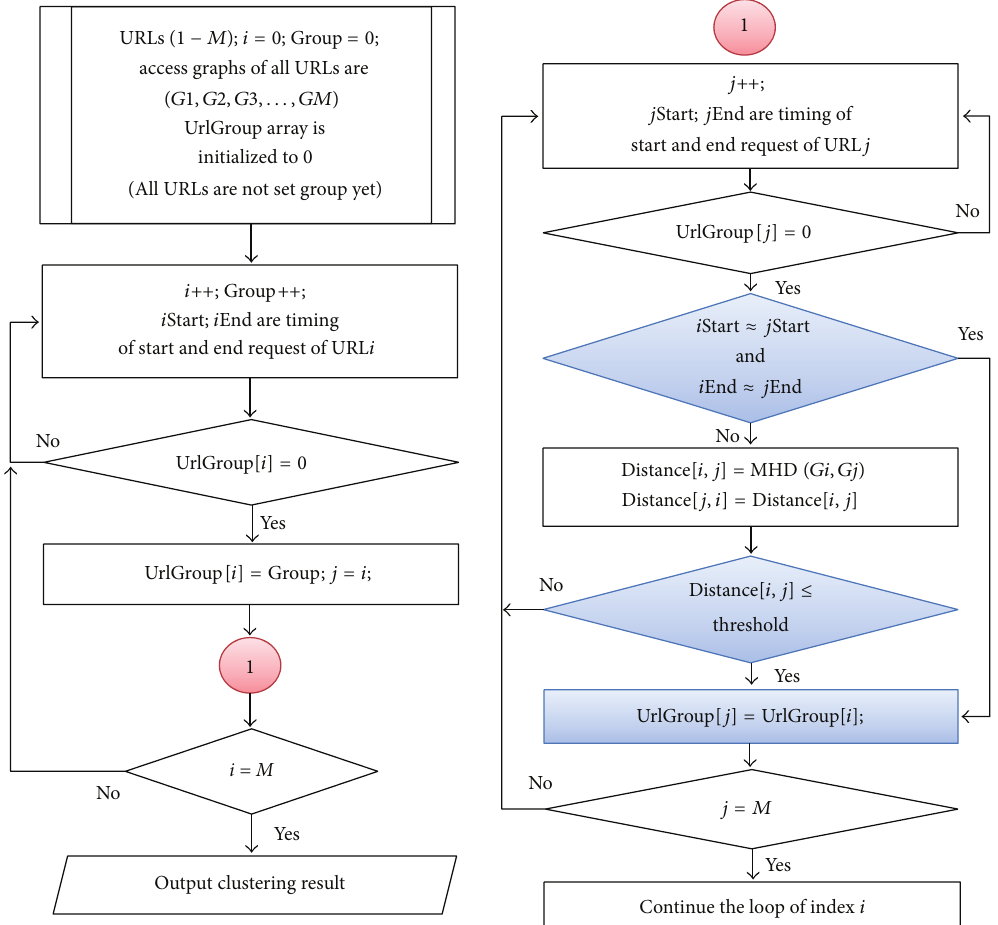
Figure 8: Autoware communication clustering